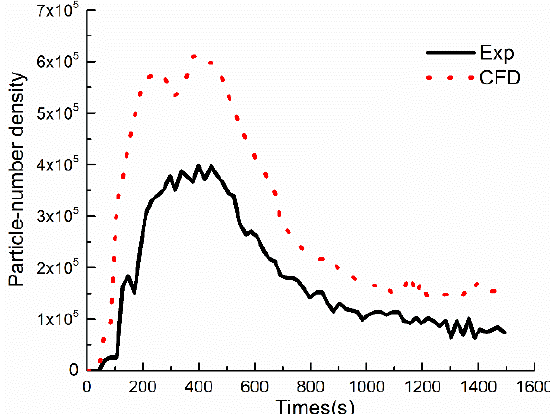
Figure 6. The test chamber diagram, point 1 is the measurement location.